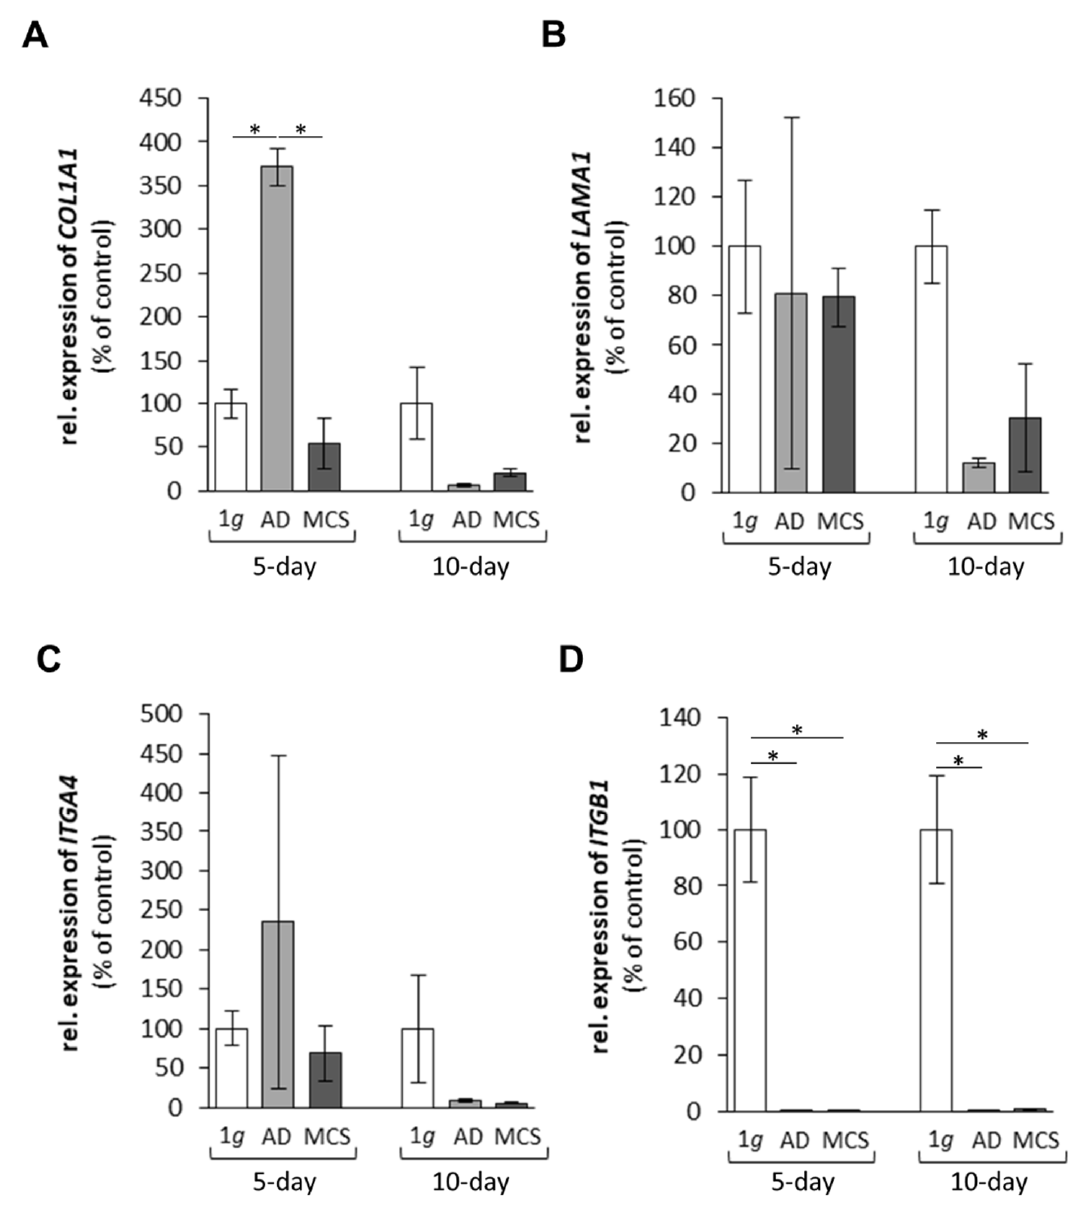
Figure 2. Gene expression of ( A ) COL1A1 , ( B ) LAMA1 , ( C ) ITGA4 , and ( D ) ITGB1 of FTC-133 follicular thyroid cancer cells grown in space on the International Space Station for 5 and 10 days. * p < 0.05 versus 1 g ground control cells. Values are presented as the mean ± standard deviation in percent of 1 g ground controls, which was fixed as 100% for each condition. AD corresponds to adherent cells; MCS corresponds to multicellular spheroids. 5-day spaceflight/1 g ground control samples, n = 3; 10-day spaceflight samples/1 g ground control, n = 2.